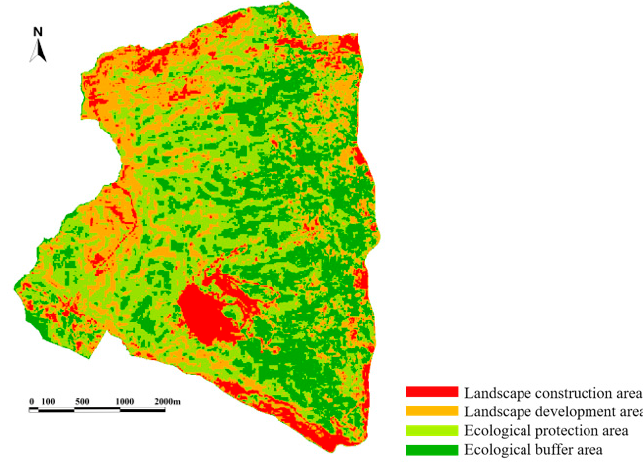
Figure 5. Ecological-resistance surface of Tianmeng Mountain Scenic Spot.